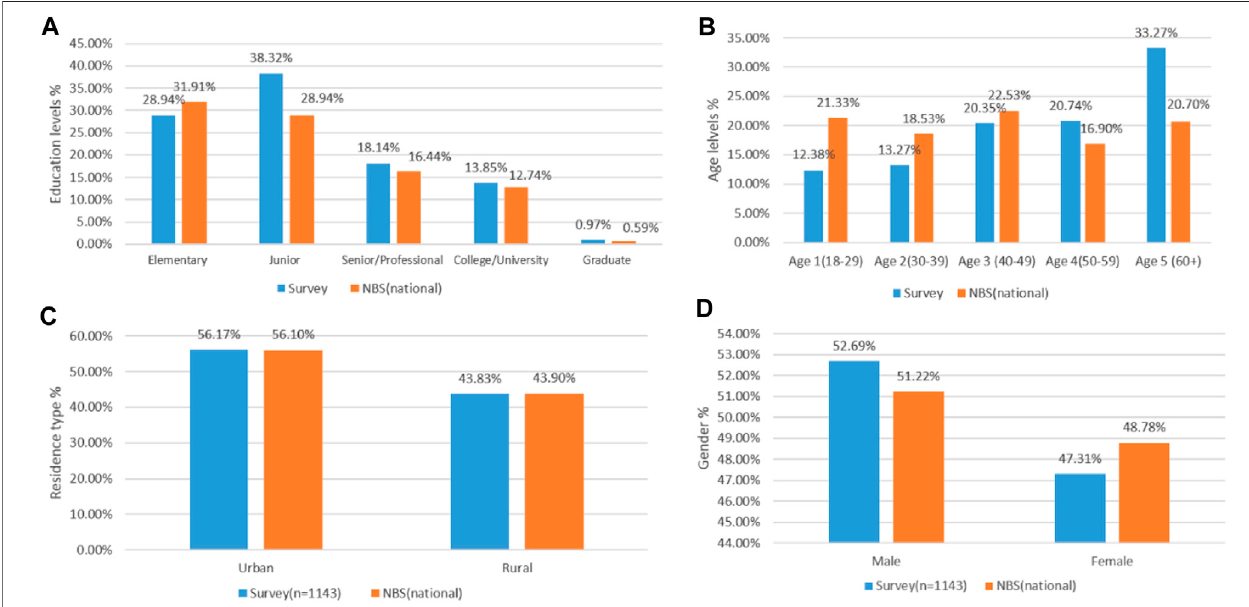
FIGURE 1 | Major socioeconomic attributes: survey samples and national distribution. (A) education level; (B) age level; (C) residence type; (D) gender.